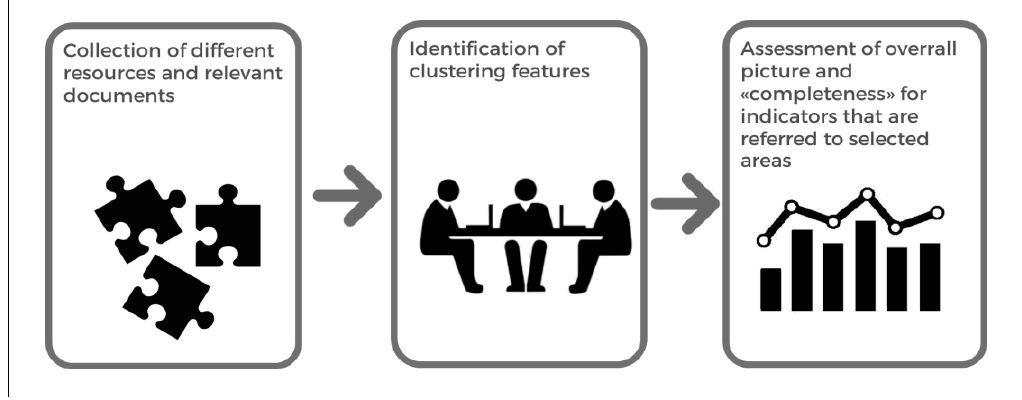
Figure 4: Bottom up Approach for Indicator